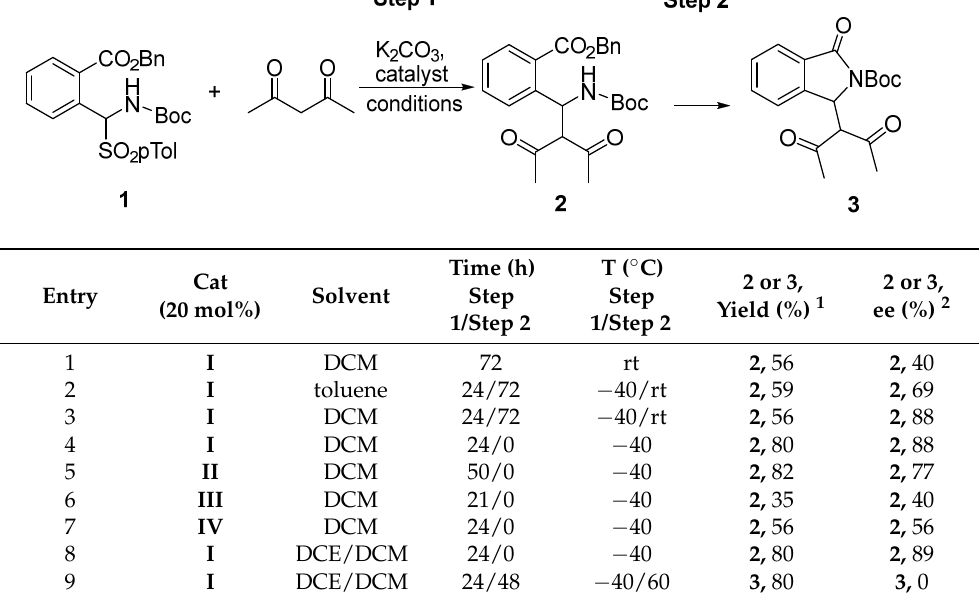
Figure 2. Organocatalysts investigated in this methodology. Table 1. Reaction conditions investigation of the two-step process with chiral organocatalysts.